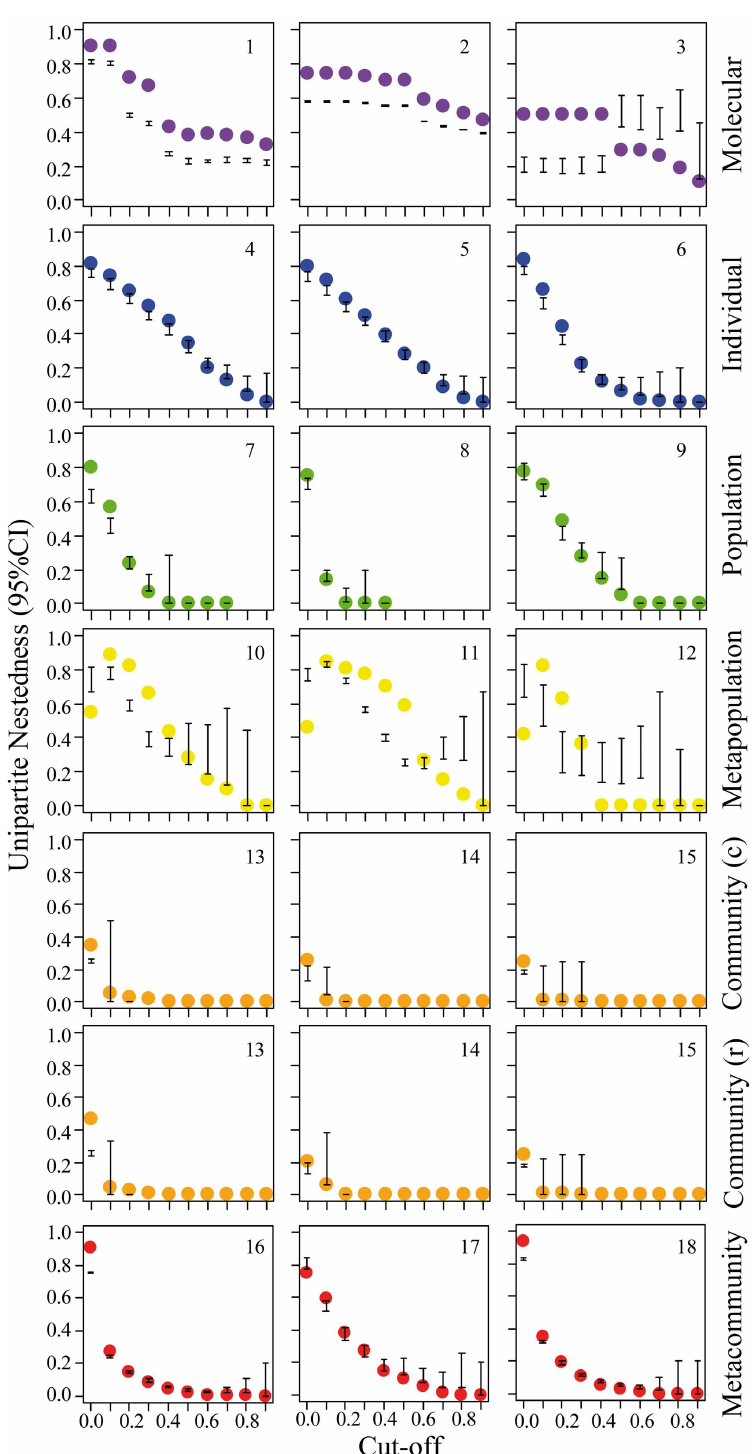
Fig 4. Nestedness ( UNODF ) across different cut-off levels for biological one-mode networks across six organization levels. We convertedthe weights of links in the originalnetwork to 0’s or 1’s using a successivethreshold analysis(see Methods,S2 Fig). The UNODF values calculatedfor each cut-off (filled circles: empiricalvalue) was comparedwith a benchmark null distributiongeneratedby a null model (whiskers: 95% confidenceintervals) that accounts for network size and connectance(see Methods). For the